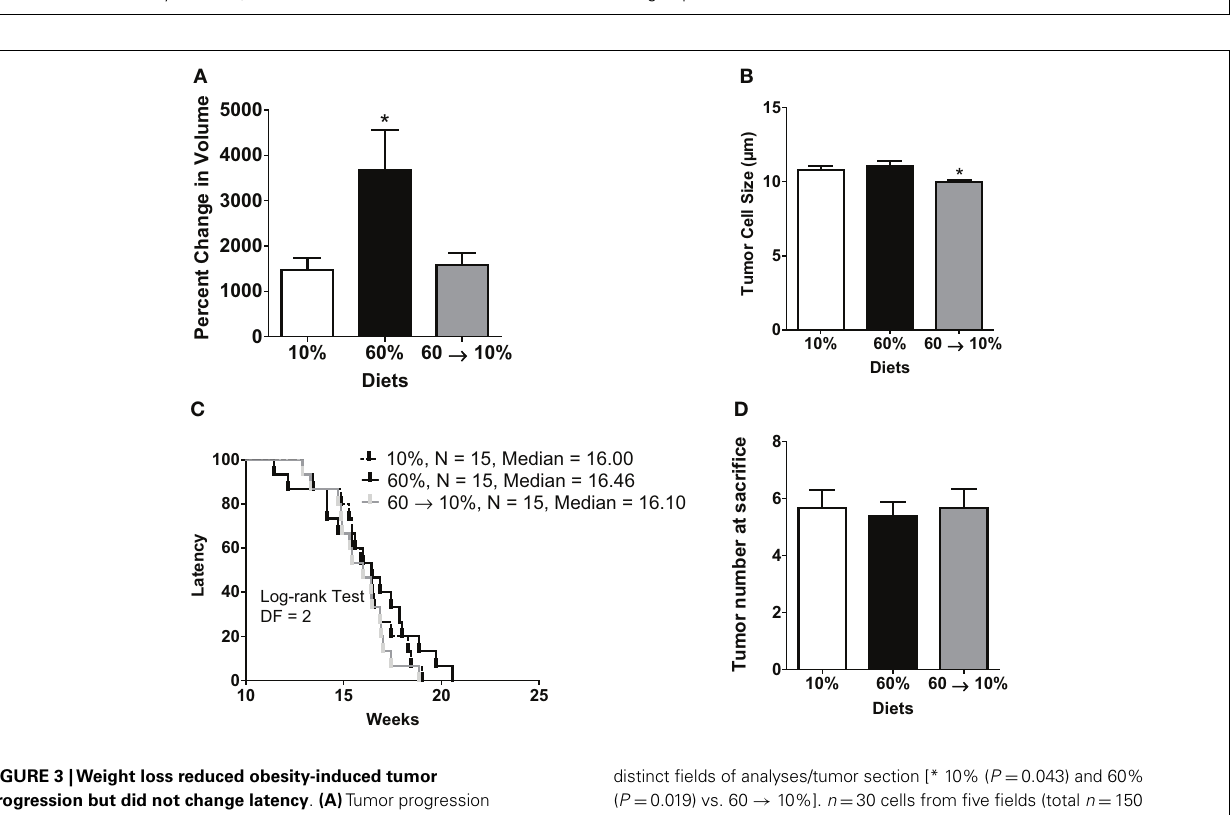
FIGURE 2 | Diet crossover induced loss of weight and fat mass compared to obese C3(1)-T Ag mice . (A) C3(1)-T Ag mice were weighed weekly at start of diets at weaning (3weeks of age) (* P = 0.001 from weeks 9 to end of study vs. 60%; ∧ P = 0.01 from weeks 11 till sacrifice vs.